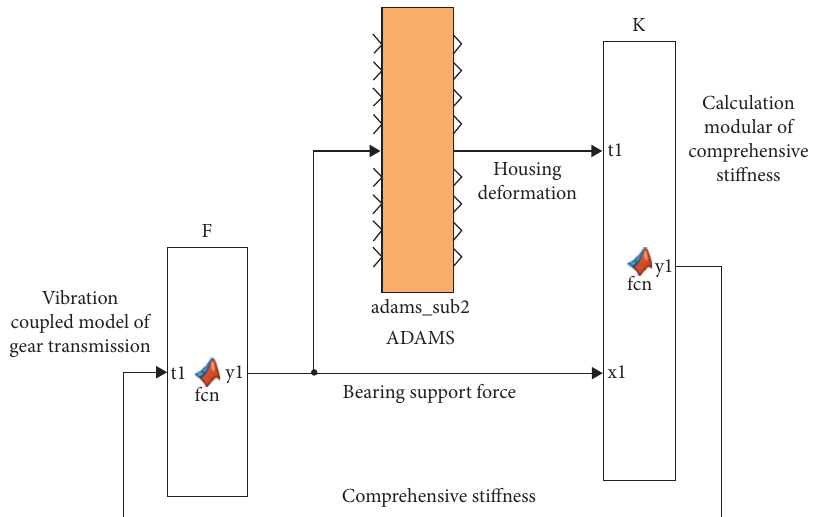
Figure 12: Comprehensive stiffness solution model (Simulink).